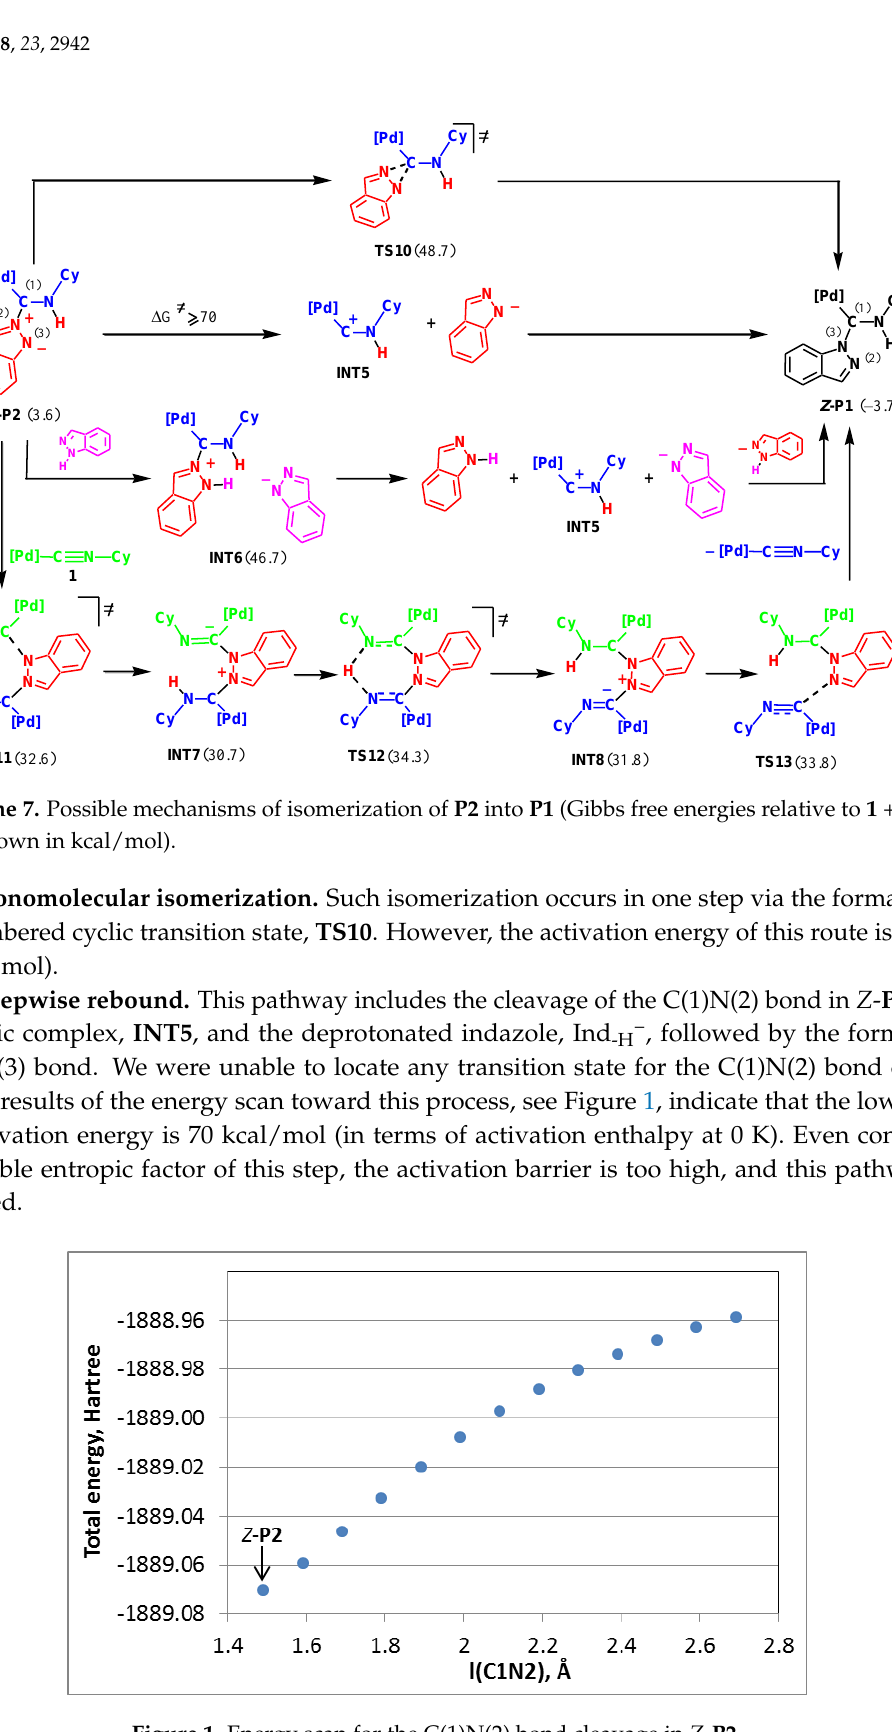
Figure 1. Energy scan for the C(1)N(2) bond cleavage in Z - P2 .